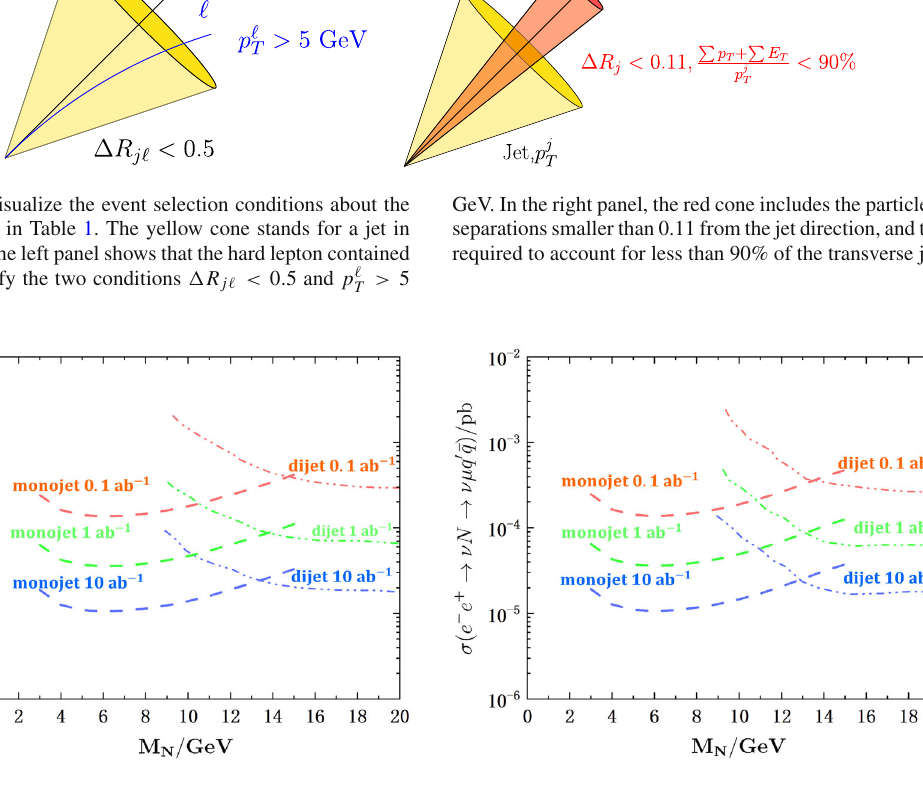
Fig. 4 The upper bounds on the cross sections σ( e + e − → ν N → ν(cid:3) q (cid:3) ¯ q ) at 95% CL given by future Z -factories with three setups of integrated luminosities L = 0 . 1 , 1 and 10 ab − 1 , using the monojet and dijet [61]